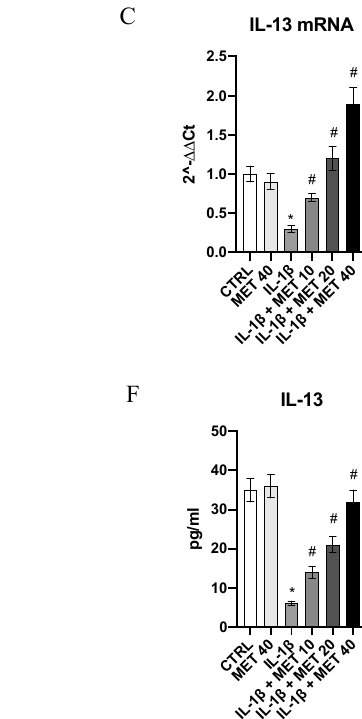
Figure 1. Effects of metaxalone on TNF- α ( A ), IL-6 ( B ), and IL-13 ( C ) mRNA expression. Effects of metaxalone on TNF- α ( D ), IL-6 ( E ), and IL-13 ( F ) protein levels. Values are expressed as the means ± SD. *, p < 0.0001 vs. CTRL; #, p < 0.0001 vs. IL-1 β .